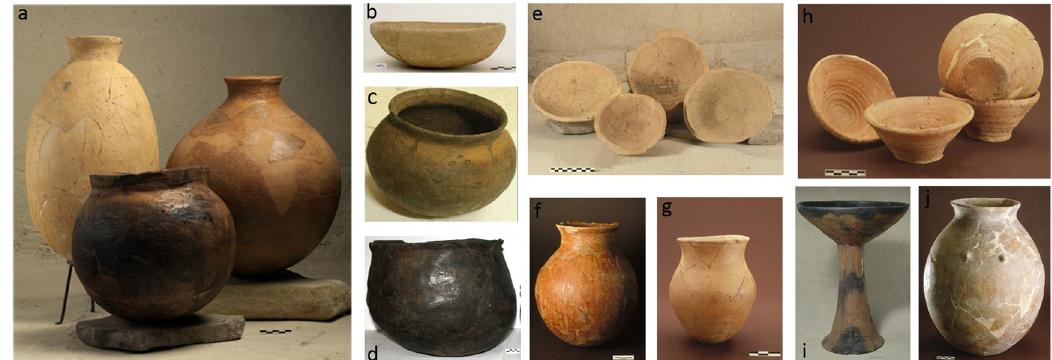
Fig 2. Examples of LC pottery from Arslantepe. a. LC1-2 storage jars and kitchen wares; b. LC1-2 handmade Coba Bowl; c. LC3-4 wheel-finished cooking pot; LC3-4 handmade cooking pot; e. LC3-4 wheel-finished mass-produced bowls; f. LC3-4 wheel-finished red-slipped ware (RIB) small jar; g. LC5 wheel-made light-colored fine ware jarlet; h. LC5 wheel-made light-colored coarse ware mass-produced bowls; i. LC5 handmade red-black burnished ware high-stemmed bowl; j. LC5 handmade kitchen ware and storage jar. Image: Archive of the Missione Archeologica Italiana in Anatolia Orientale (MAIAO).